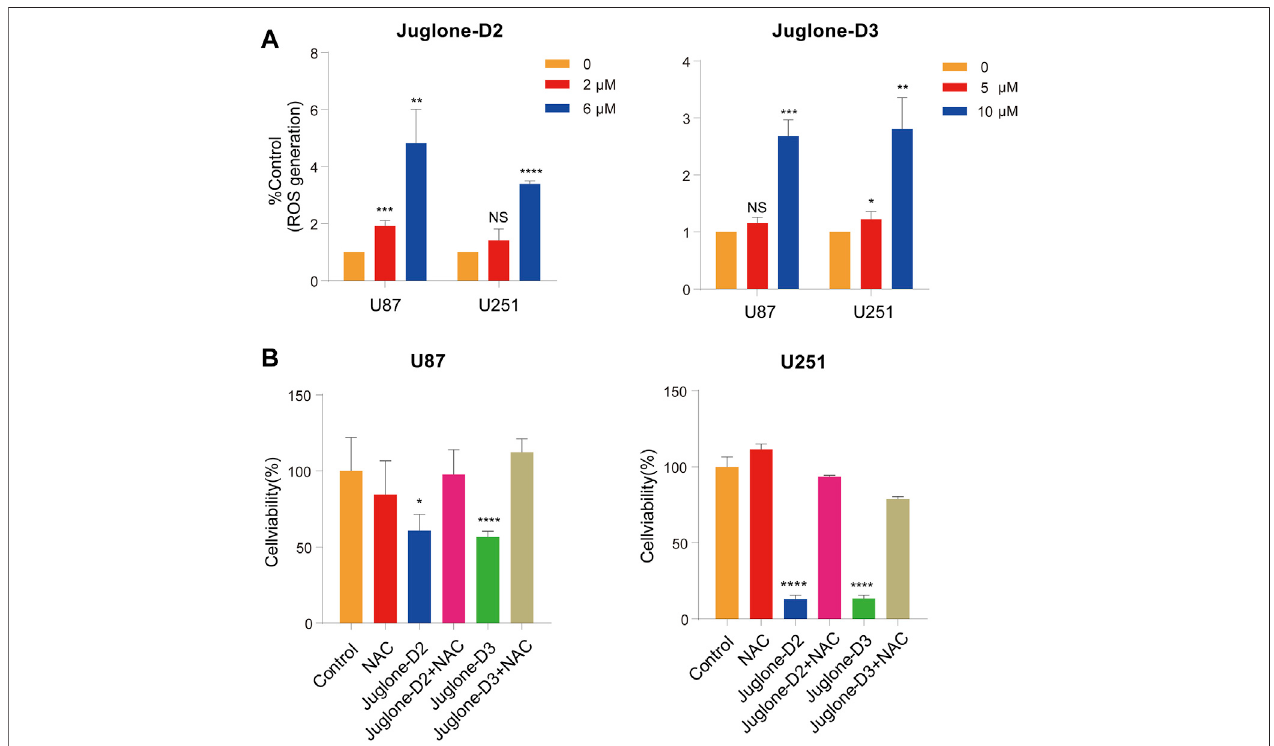
FIGURE 6 | The cytotoxic effect of juglone derivatives is dependent on ROS generation. (A) The ROS generation was increased after treatment of D2 and D3. (B) NAC, a ROS scavenger, could reverse the cytotoxic effect of ROS. * p < 0.05, ** p < 0.01, *** p < 0.001, **** p < 0.0001.